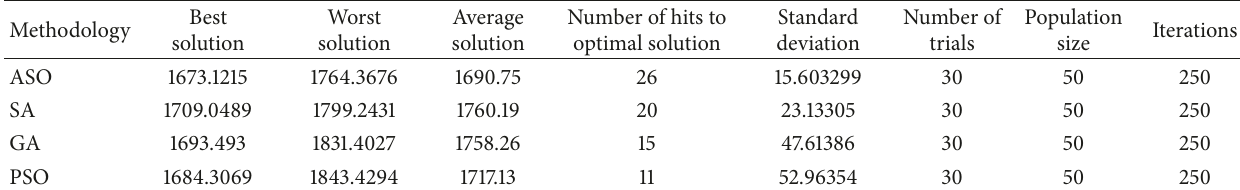
Table 7: Operation cost comparison for Case 1 (30 trials),